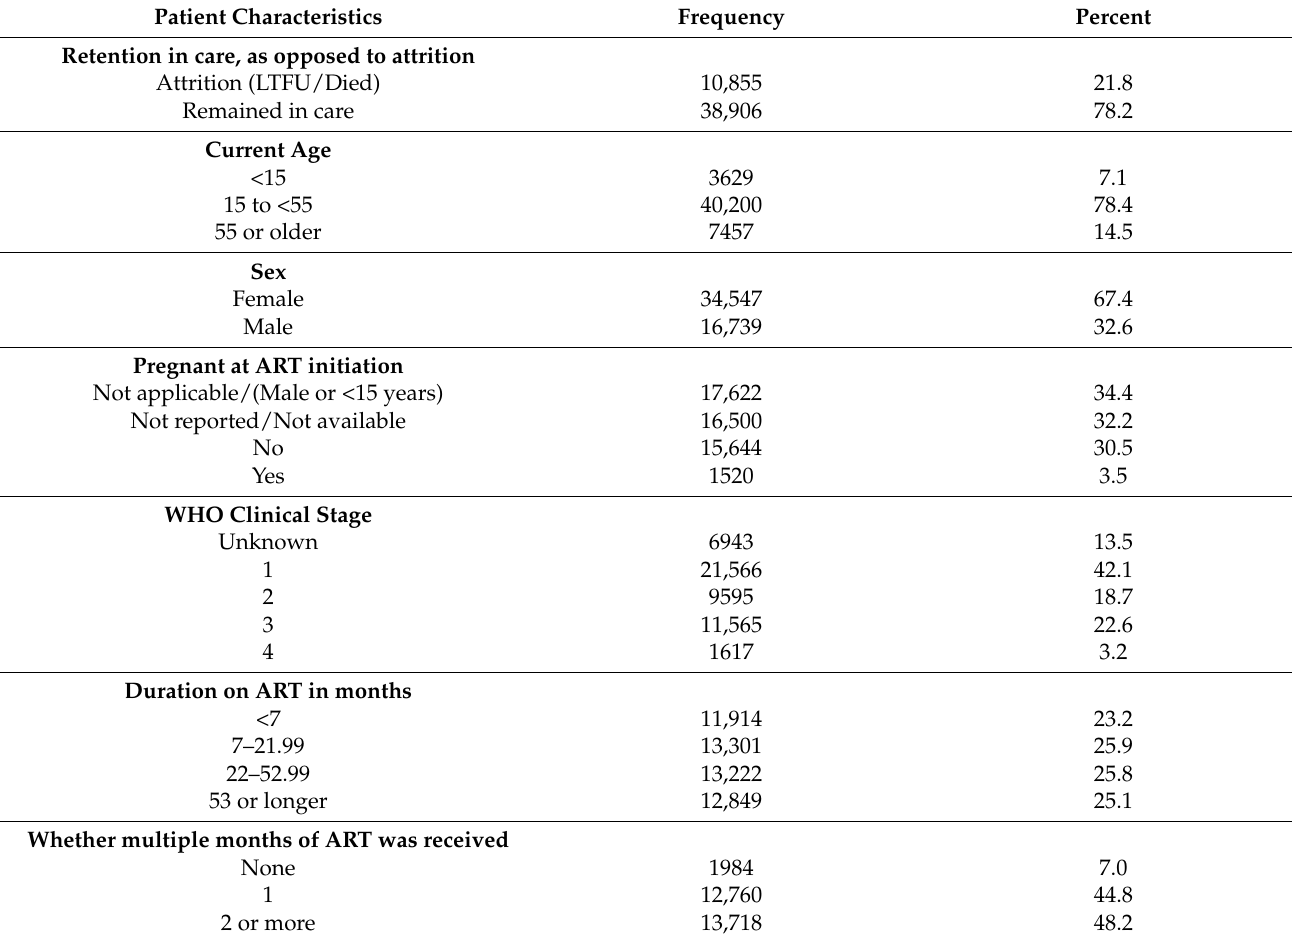
Table 1. Descriptive statistics for characteristics of clients in HIV/AIDS clinics of Haut-Katanga and Kinshasa Provinces, DRC,